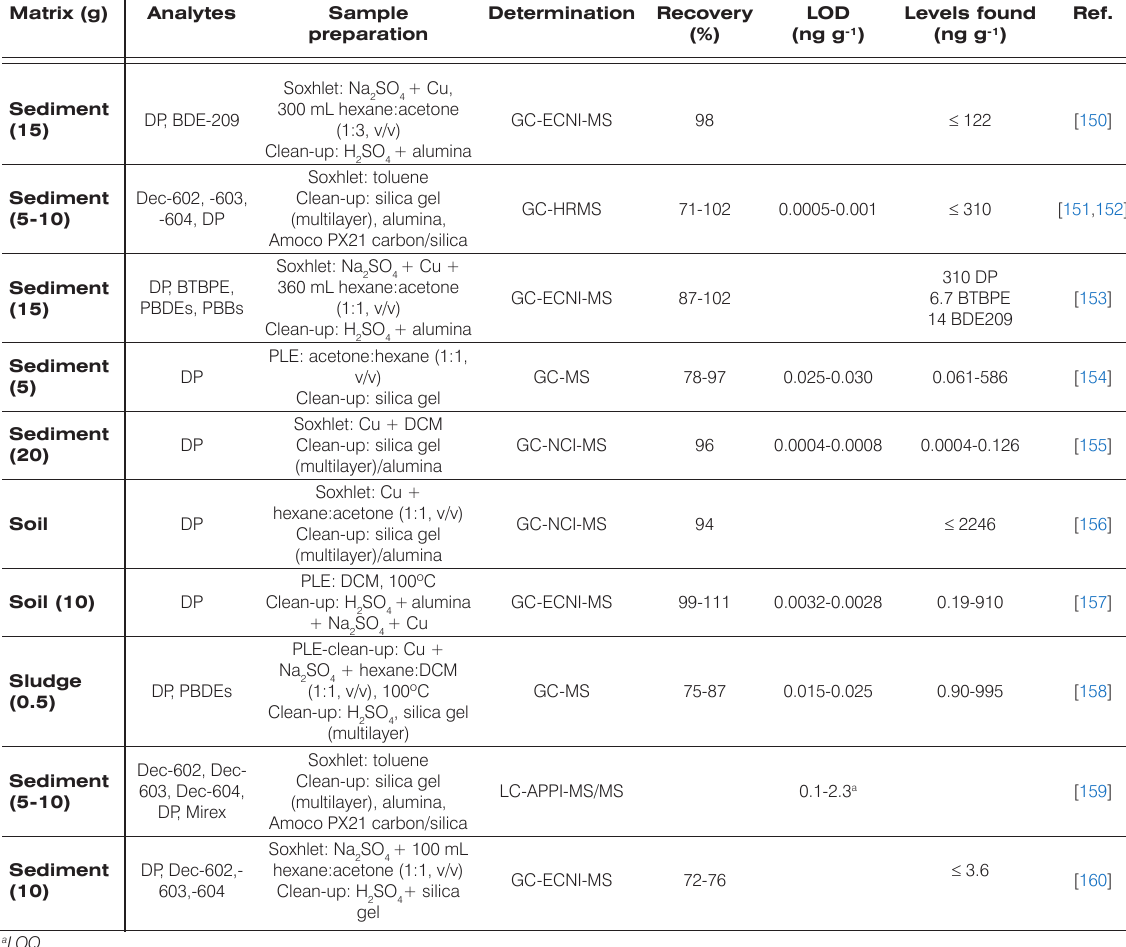
Table 6. Analysis of DP and related compounds in environmental solid